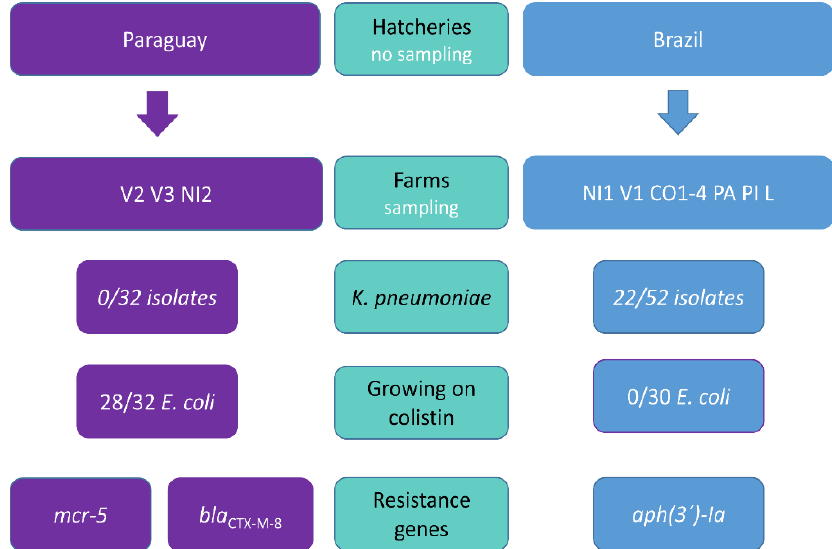
Figure 1. Schematic comparison of farms which purchased chickens from the Paraguayan hatchery and from the Brazilian hatchery regarding the most important findings suggesting that the hatchery level could play an important role in the chicken gut colonization and related antibiotic resistance carried by the bacteria. One-day chickens were transferred to the farms from hatcheries and sampled as finisher chickens (28-days old). Farm labels consist of the village name and farm number (Villeta: V1–3; Nueva Italia: NI1-2; Colonel Oviedo: CO1–4; Paraguari: PA; Piribebuy: PI; Luque: L). The scheme compares the number of obtained Klebsiella pneumoniae isolates to total number of obtained isolates in farms which purchased chicken from respective hatchery; the ability of E. coli isolates to grow on media with 3.5 mg/L colistin; and shows which antibiotic resistance genes presence clearly differed with respect to the hatchery, placing the specific gene with the respective hatchery for which it was typical.